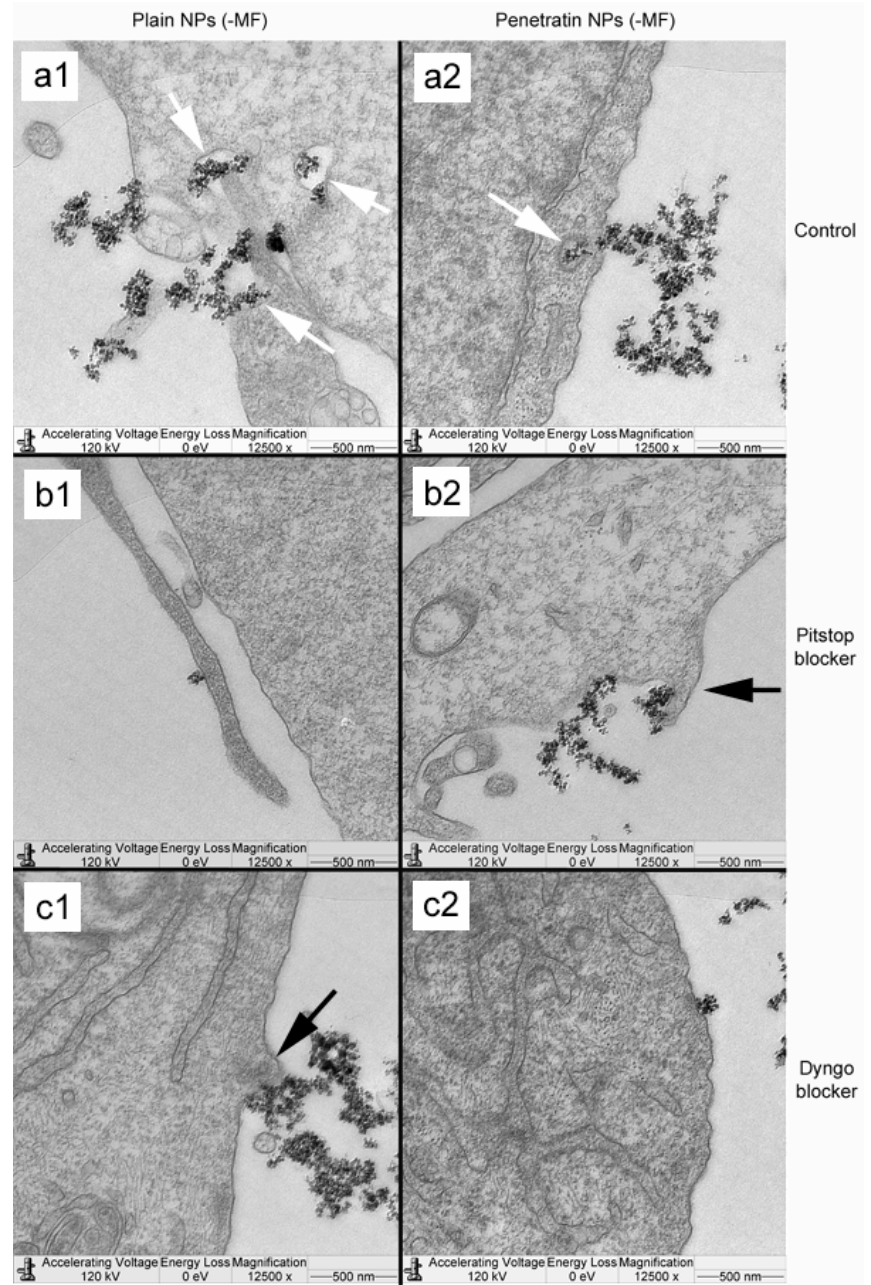
Figure 9. TEM micrographs showing cellular uptake of plain and penetratin functionalised NPs in the absence of a magnetic field. Control cells (no blockers; a1 and a2), cells incubated in Pitstop (b1 and b2) and cells incubated in Dyngo (c1 and c2). Note the cell membrane invaginations and vacuole formations indicative of endocytosis (white arrows) and the membrane extrusions indicative of pinocytosis (black